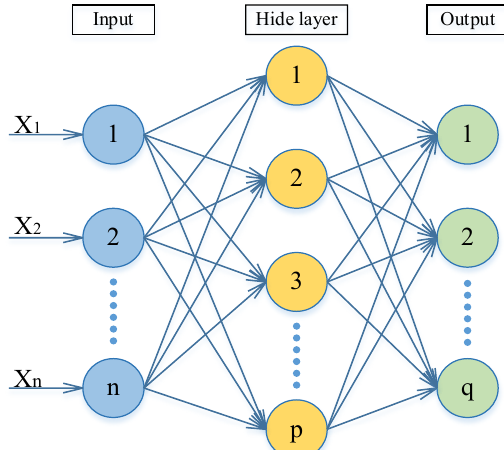
Figure 6. BP neural network flow chart.